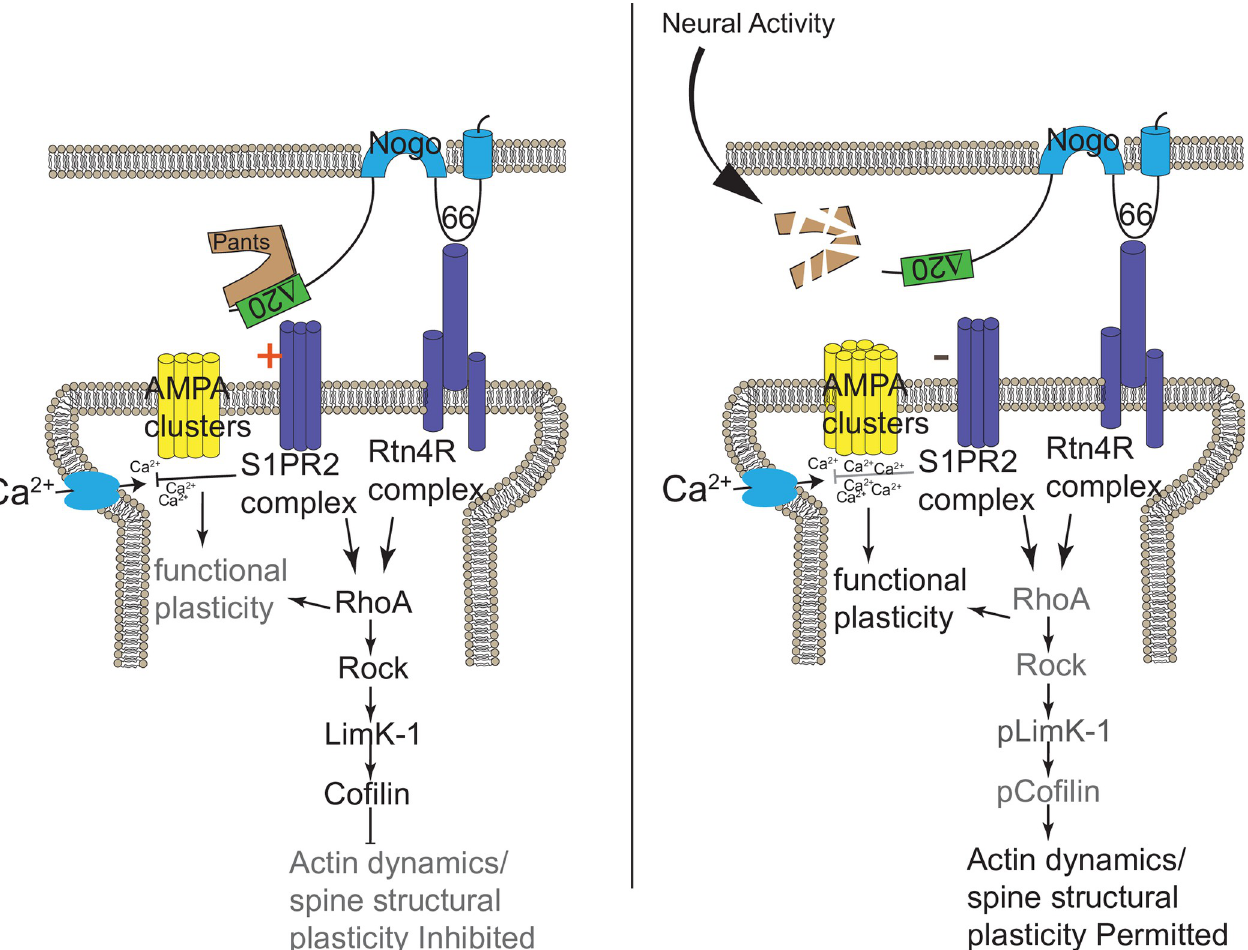
Fig 8. Model for the mechanism of Pants control of plasticity. Pants stabilizes the interaction of Nogo-A with receptors, inhibiting clustering of postsynaptic AMPA receptors at synaptic sites. Upon stimulation, Pants is degraded at synapses, reducing Nogo-A signaling and allowing AMPA receptor clustering at individual